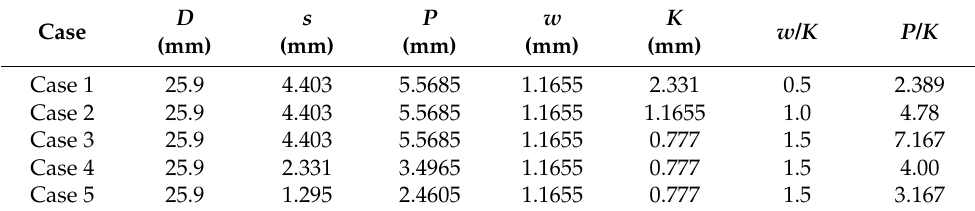
Figure 1. Explanations of the geometrics on the corrugated pipe. Table 1. Parameters of corrugated pipe for numerical analysis.